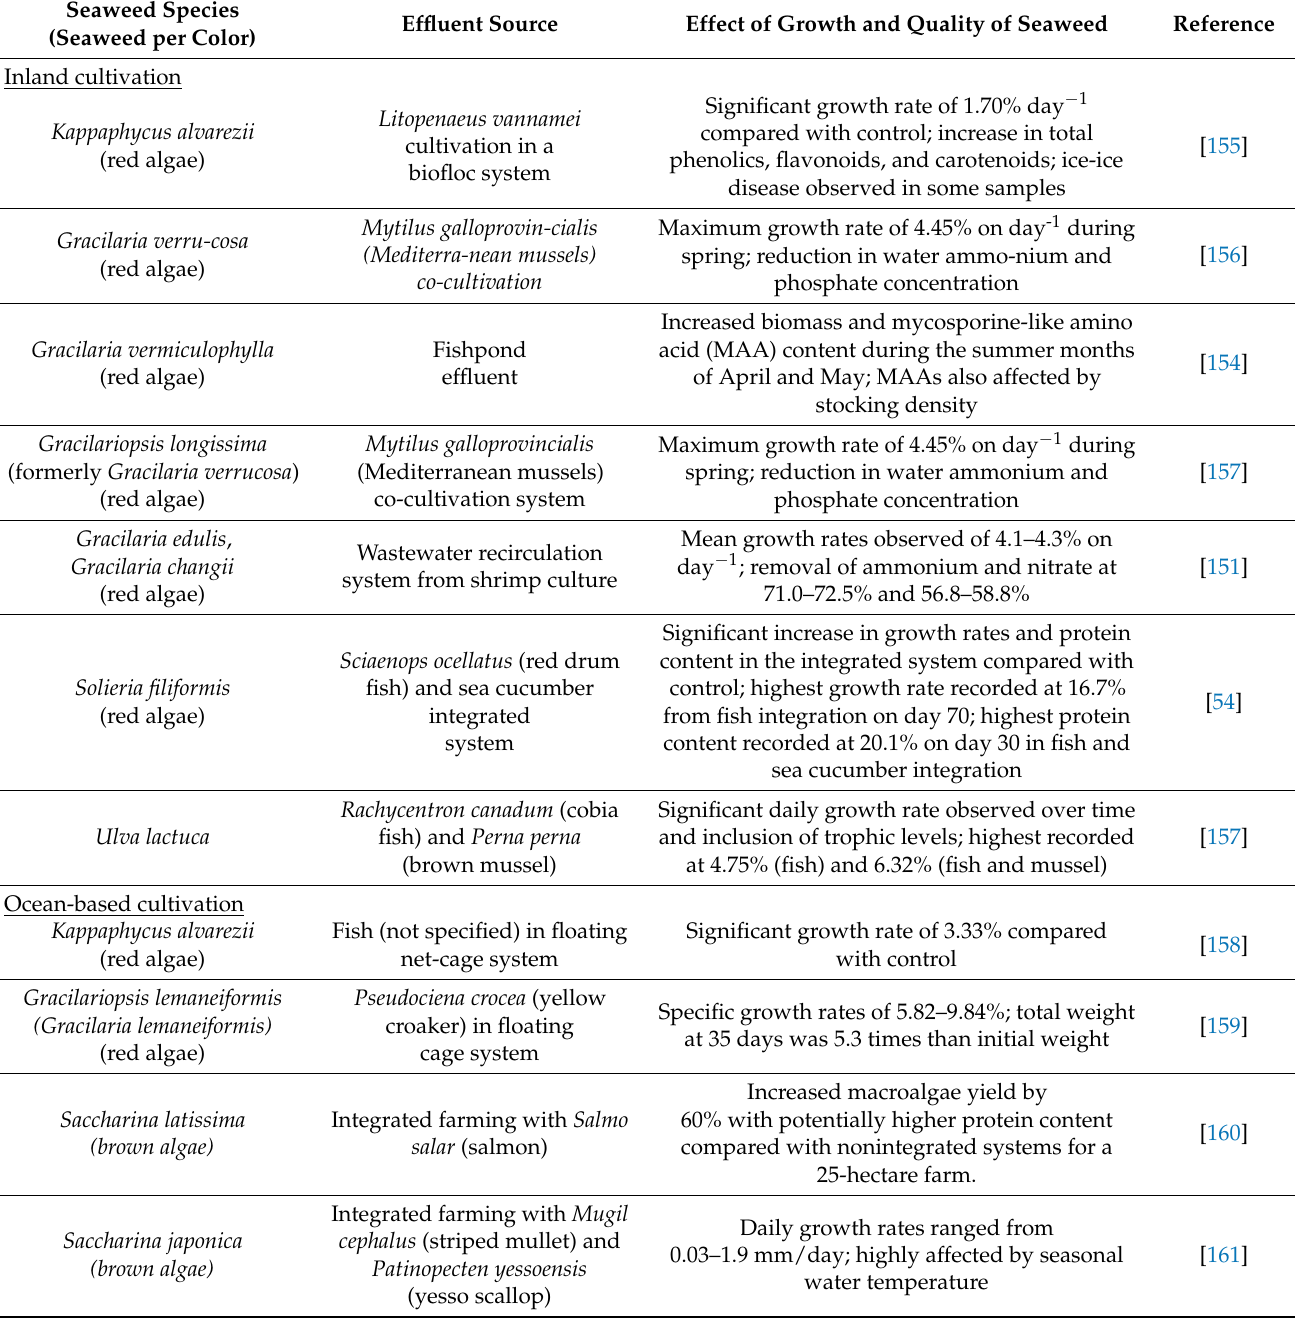
Table 2. The IMTA systems and bioremediation strategies of offshore and inland cultivation of some commercial